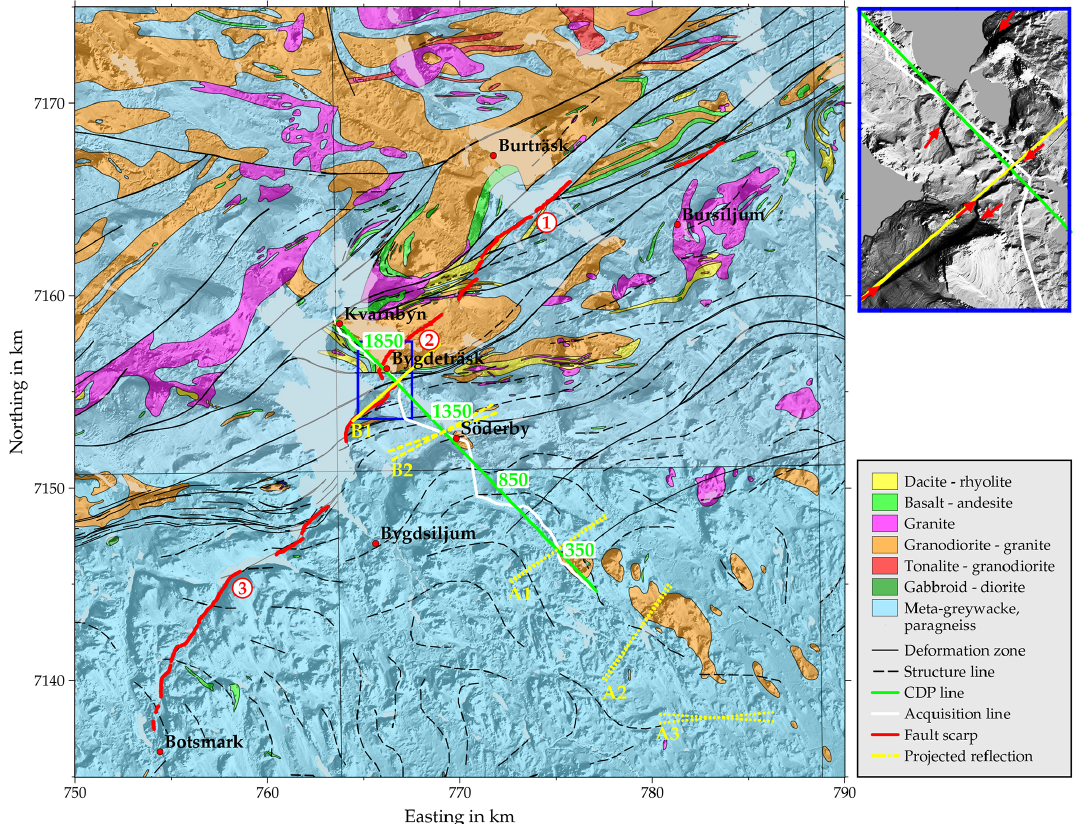
Figure 2. Geological map of the survey area and location of the Burträsk profile. The Burträsk fault (red line) can roughly be divided into three parts, marked with the red numbers. The yellow lines mark the surface projection of reflector planes corresponding to the most prominent reflections in the seismic data with solid lines used for well-constrained surface locations and dotted lines for poorly constrained locations. Note that the actual reflection points are shifted laterally for reflectors with a large cross-dip component. The map inset shows an enlargement of the fault scarp and the red arrows indicate the location of the fault scarp. The location of the map is indicated in Fig. 1. Geological map © Geological Survey of Sweden; elevation data ©